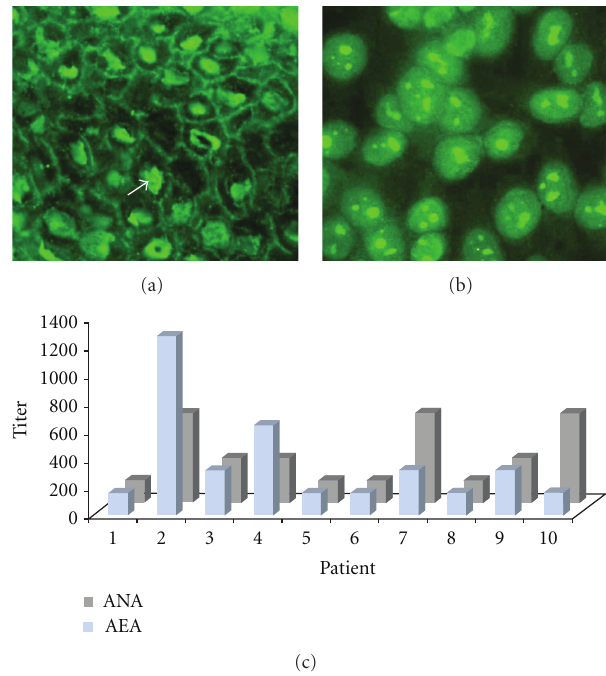
Figure 1: (a) Indirect immunofluorescence in cow nose tissue showing a honeycomb fluorescence pattern along intercellular junctions of keratinocytes that is characteristic of pemphigus and a nuclear fluorescence pattern for ANA. (b) The same serum sample was tested in HEp-2 cells, resulting in a homogeneous nuclear and nucleolar pattern. (c) Graph of individual titers of each serum